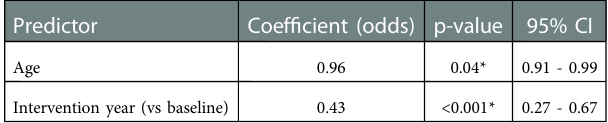
Table 2 Logistic regression exploring the odds of having received an urgent repeat C-section based on whether the delivery occurred during the baseline year or intervention year. The model was adjusted for age. n= 355, * = p<0.05 Predictor